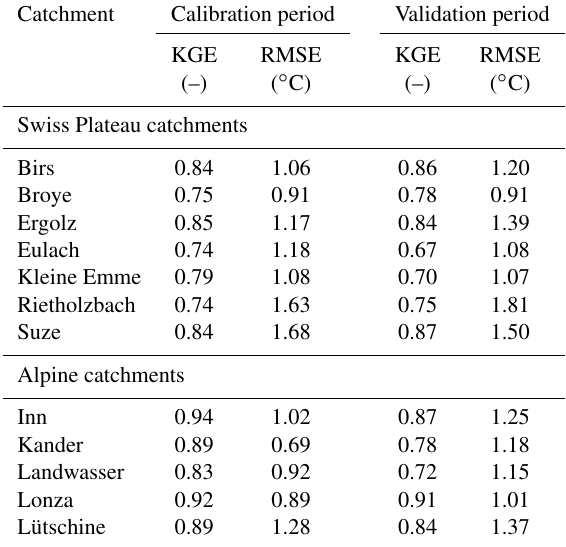
Table 4. Performance of the StreamFlow model during the cal- ibration and validation periods evaluated with Kling–Gupta effi- ciency (KGE) for discharge and root mean square error (RMSE) for water